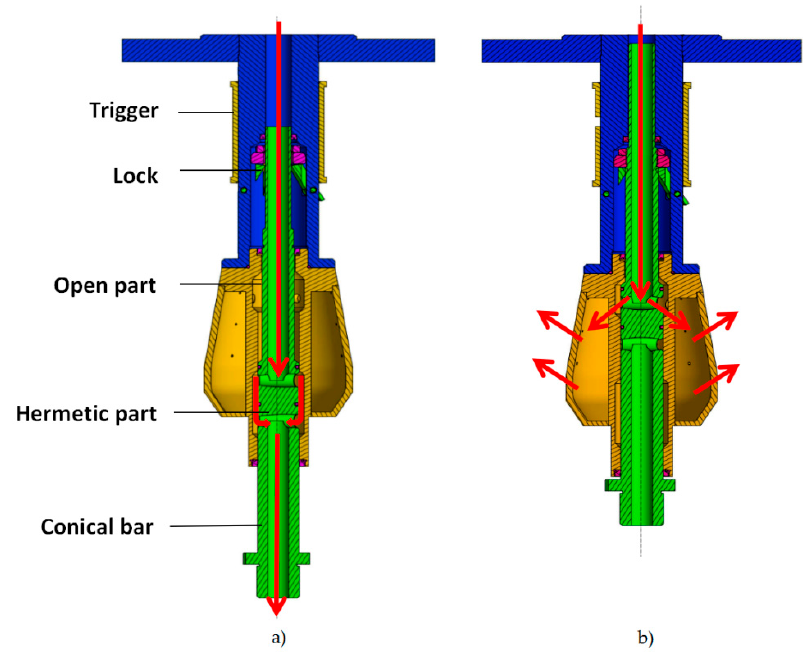
Figure 5. The two drilling positions: ( a ) the coring position; ( b ) the back drilling position.